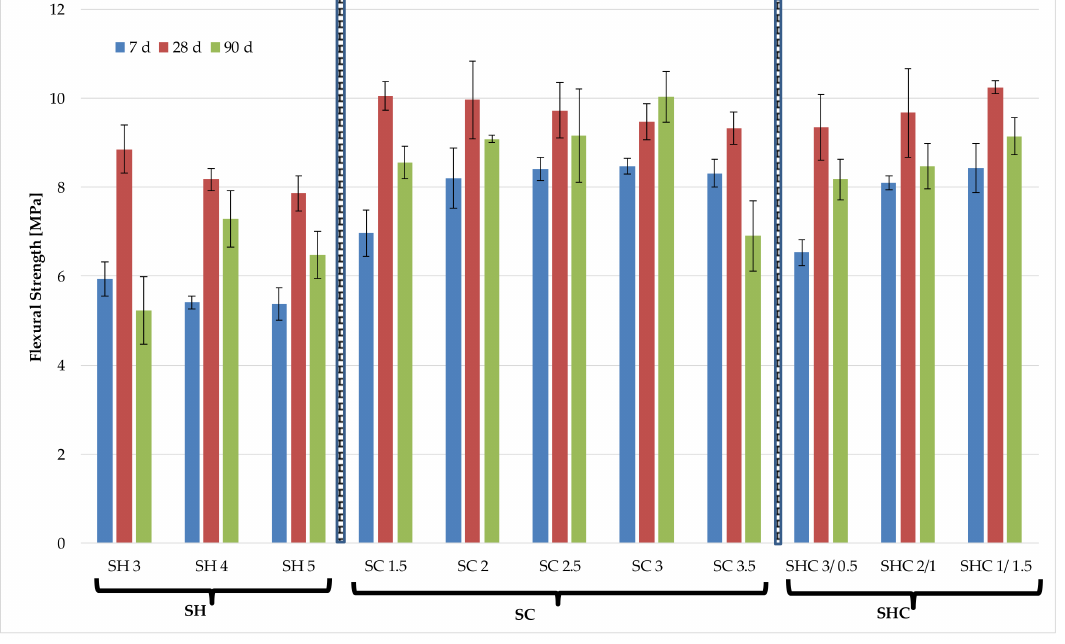
Figure 4. Flexural strength (Rf) of mortars for 3, 28 and 90 curing